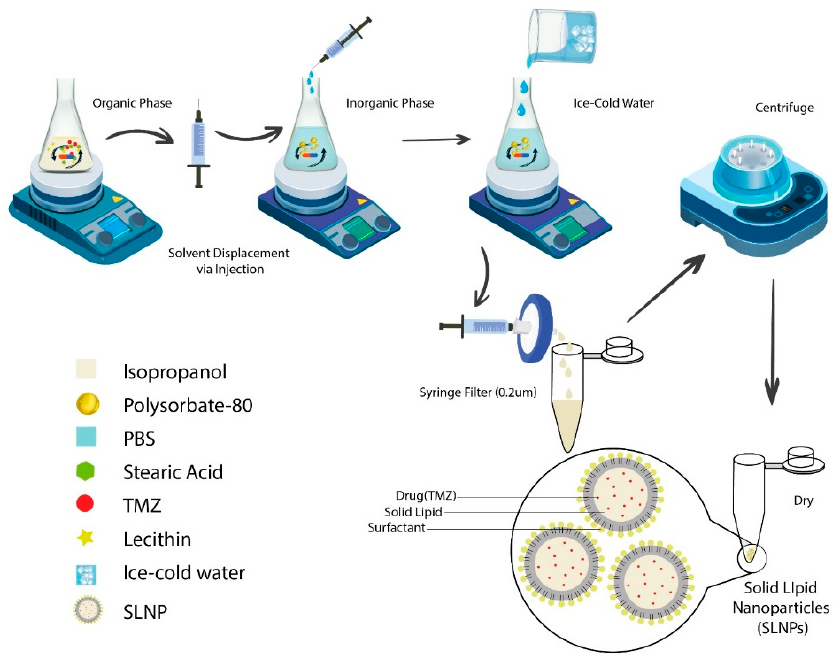
Figure 1. Graphical representation of the formation of temozolomide-loaded solid lipid nanoparticles (SLNP-TMZ) via the hot injection method and emulsification protocol. The ingredients of the organic and inorganic solutions were mixed separately using a hot magnetic plate. The organic phase was dispersed into an inorganic phase drop-by-drop via injection. Ice cold water was added, the solution was centrifuged, and the pallet was dried and stored.